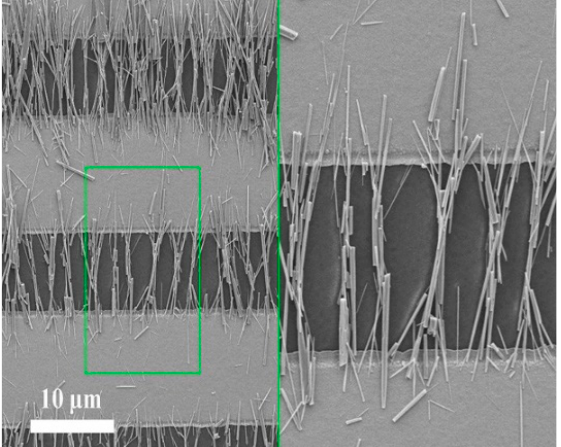
Figure 10. Assembly of nanowire on a micro-hotplate [55].